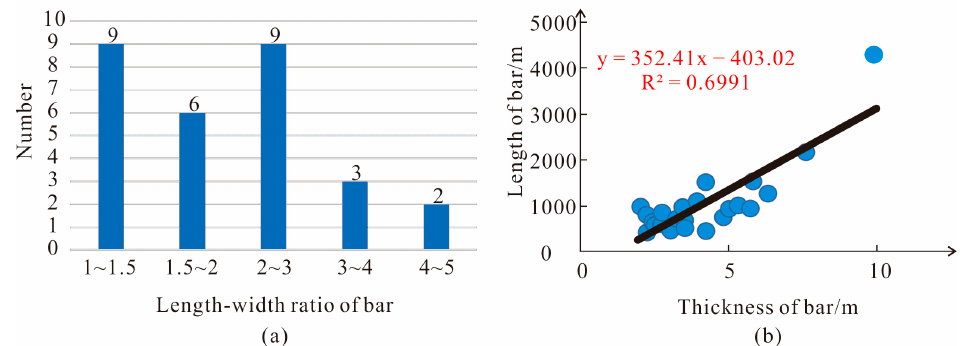
Figure 6. ( a ) Statistical diagram of length-width ratio of bar sand; ( b ) relationship between length and thickness of bar